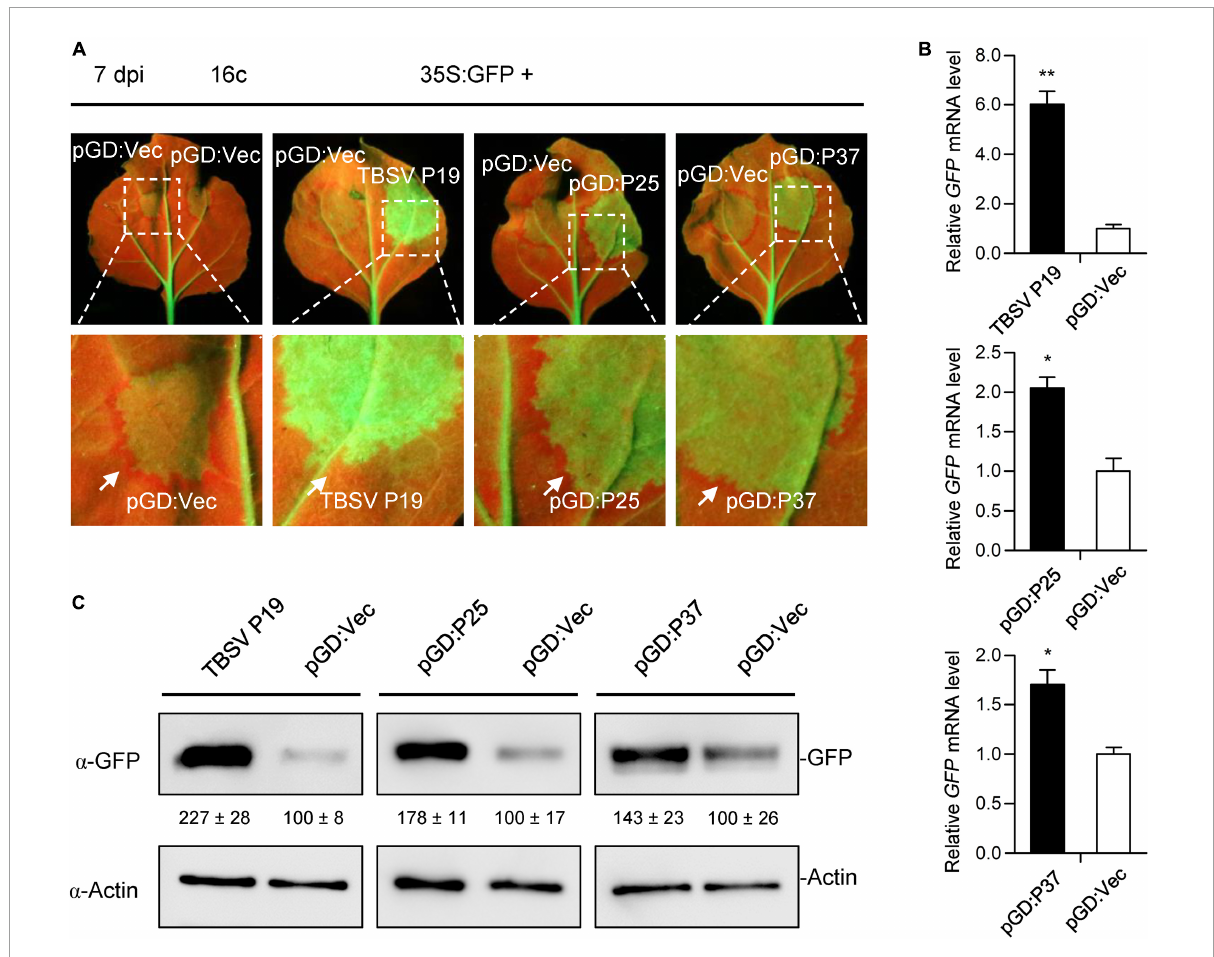
FIGURE3 Firespike leafroll-associated virus (FLRaV) P25 and P37 can inhibit the post-transcriptional gene silencing (PTGS) of local green fluorescent protein (GFP) in 16c Nicotiana benthamiana . (A) Leaves of 16c N. benthamiana seedlings were co-infiltrated with Agrobacterium tumefaciens harboring the binary vector expressing GFP (35S:GFP) and either an empty pGD vector (pGD:Vec), TBSV P19, pGD:P25, or pGD:P37 at 7 days post infiltration (dpi). Leaves of 16c N. benthamiana seedlings co-infiltrated with A. tumefaciens harboring the 35S:GFP plus pGD:Vec or TBSV P19 were served as negative and positive controls, respectively. White arrows indicate the red ring around the infiltrated patches. (B) Quantitative real time PCR (qRT-PCR) analysis of the accumulation of GFP mRNA in leaf patches shown in Figure 3A . NbACT2 was utilized as the internal control. Data are presented as means ± SD of three biological replicates. Means with asterisks are significantly different (Student’s t -test; P < 0.05). (C) Western blot (WB) analysis of the accumulation of GFP protein in leaf patches shown in Figure 3A . GFP protein was detected using an antibody against GFP ( α -GFP). WB analysis of actin with an α -Actin was served as the loading